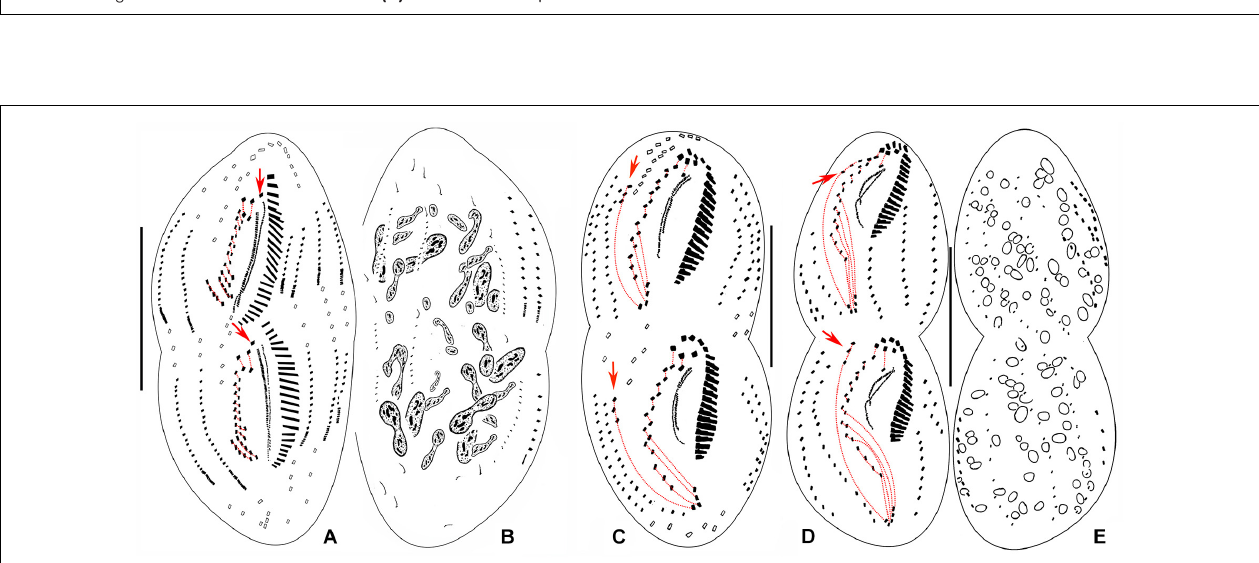
FIGURE 4 | Morphogenesis of Metaurostylopsis alrasheidi n. sp. from middle-late to late stages after protargol impregnation, hatched lines show cirri originated from the same cirral anlage. (A,B) Ventral (A) and dorsal (B) views of the same middle-late divider, arrows indicate the leftmost frontal cirrus. (C) Ventral view of a divider, arrows show the migration of newly formed frontoterminal cirri. (D,E) Ventral (D) and dorsal (E) views of the same divider, arrows mark the frontoterminal cirri migrating toward their final positions. Scale bars = 50 µ m.